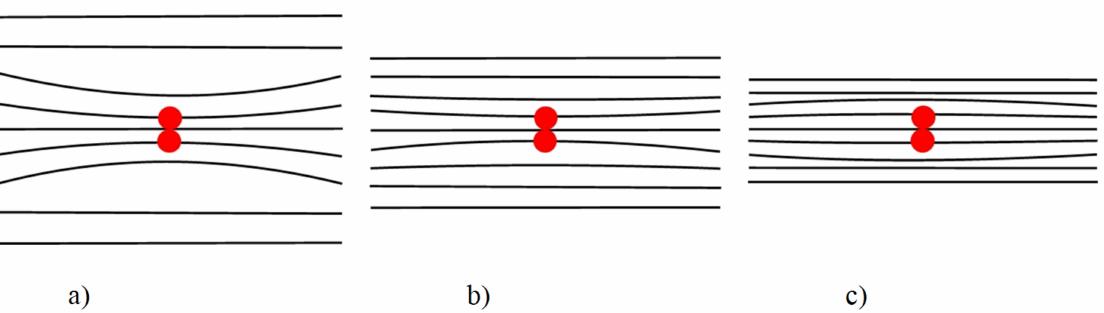
Figure 6. Schematic image of the effect of an electric voltage application on changing the sign of the crystal lattice deformation ∆ V caused by the presence of a defect (red spot): ( a ) with an increase in the crystal lattice parameters of the matrix (positive voltage application under the conditions of the described experiment) ∆ V < 0; ( b ) in the original crystal without an electric field application ∆ V < 0; ( c ) a decrease in the lattice parameters of the matrix when a negative electric voltage is applied ∆ V >